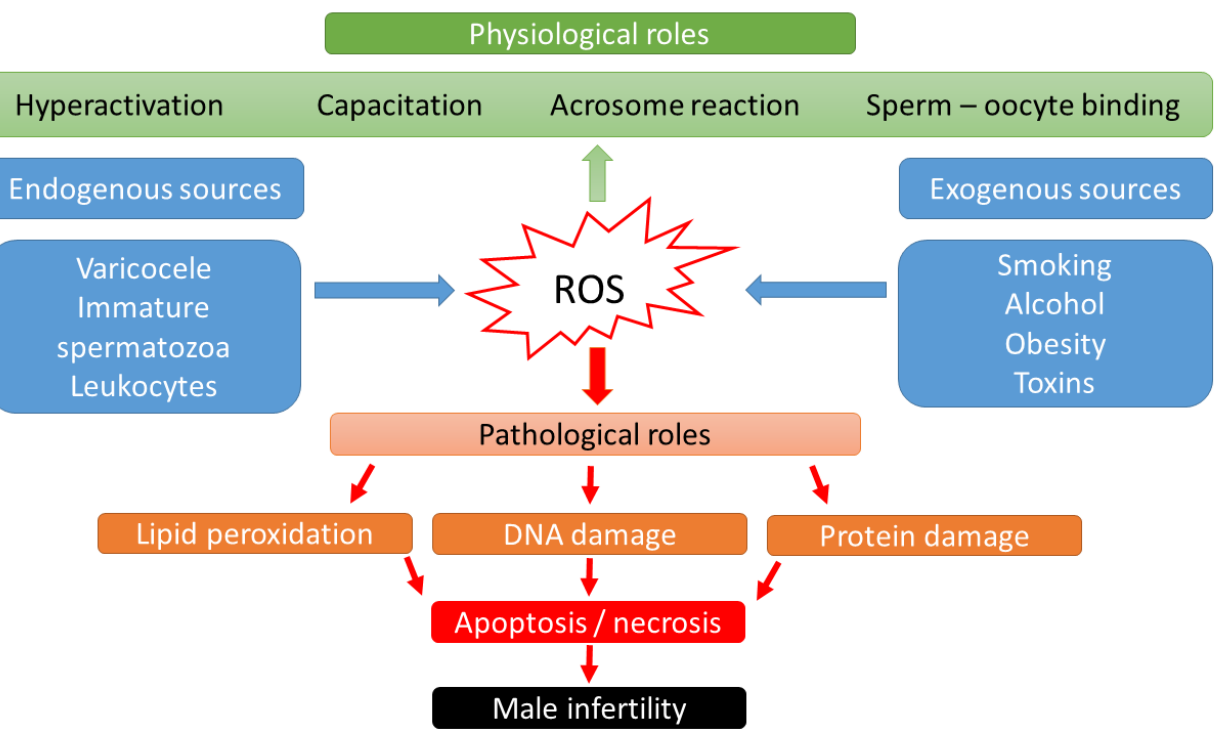
Figure 1. Scheme of physiological and pathological effects of reactive oxygen species (ROS) on male fertility.